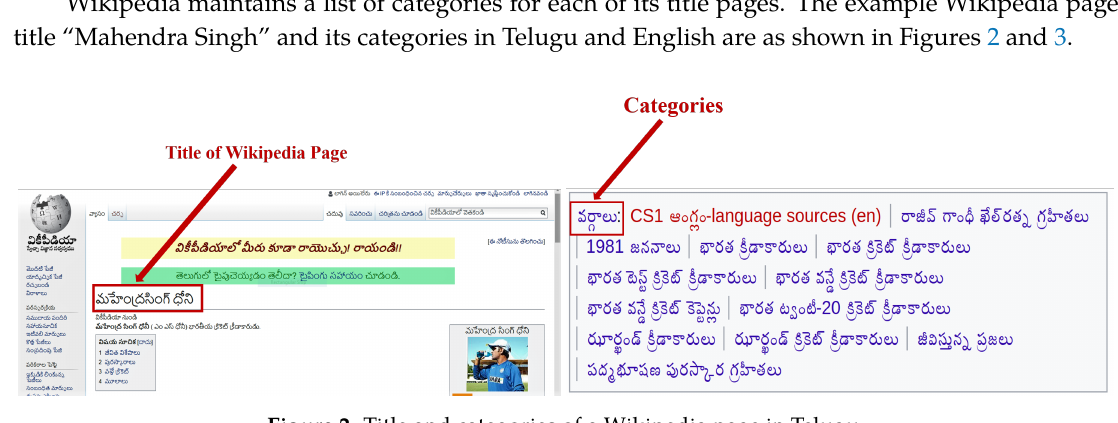
Figure 2. Title and categories of a Wikipedia page in